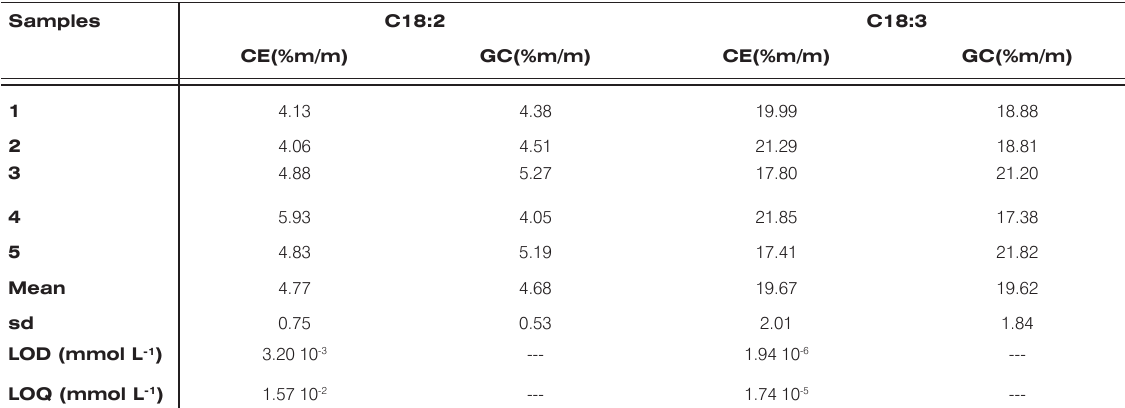
Table 4. Analysis of different forages by CE in comparison with official method by GC.